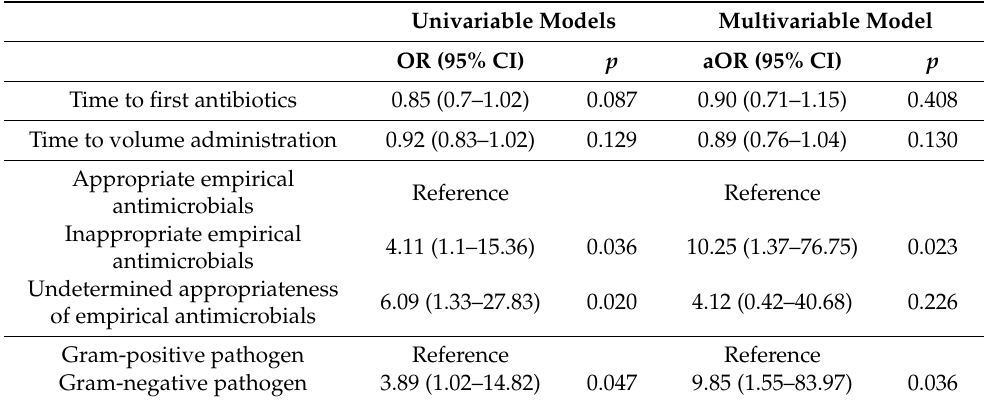
Table 2. Uni- and multi-variate analysis of association between interventions and sepsis-related mortality in late-onset sepsis among preterm very low birth weight infants.